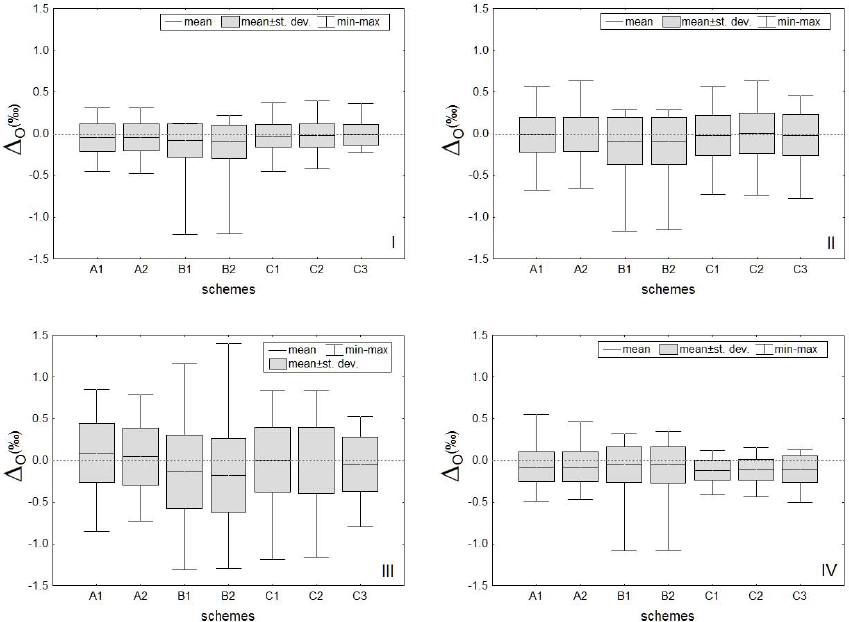
Fig. 3. Descriptive statistics of δ 18 O laser spectroscope-mass spectrometer deviations for the different analytic schemes and for the four